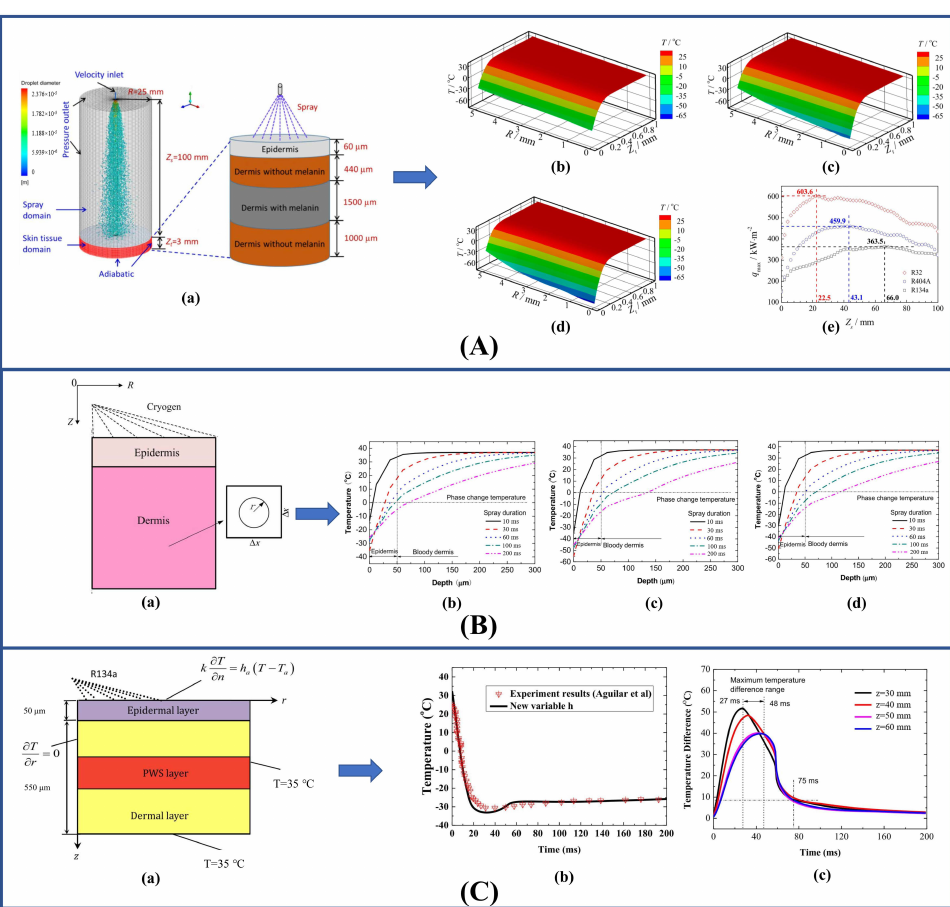
Figure 11. Skin models used in different studies and experimental results. ( A ): The Computational domain and boundary conditions that are for cryogenic spray cooling simulation ( a ); temperature distribution of axial section of skin tissue under optimal spray distance: R134A ( b ), R404A ( c ) and R32 ( d ); variations in surface heat flux from the surface along the axial jet ( e ) [168]. ( B ): Schematic of two-layer skin model and Krogh unit ( a ); the distribution curves of temperature distribution along the tissue depth with diverse spray duration by R134a ( b ), R404a ( c ), R407c ( d ) [91]. ( C ): Principles of computational boundary conditions and domain skin models ( a ); comparison of the dynamic temperature changes between surface spray center simulation results and new variable h correlation and experimental measurements of polymethyl methacrylate ( b ); the temperature difference between the center and the edge of the spray area during low temperature spray cooling ( c ) [169].